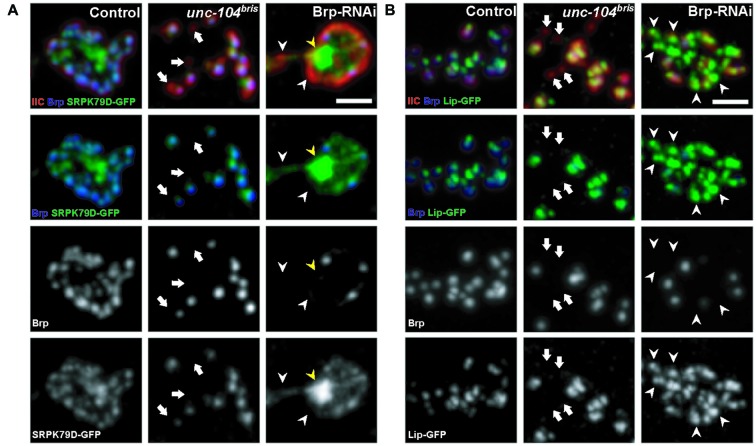
Localization of presynaptic components at the neuromuscular junction (NMJ) of unc-104bris mutant and Bruchpilot (Brp) RNAi expressing larvae. (A,B) Synaptic bouton at the NMJ costained with antibodies against postsynaptic glutamate receptor subunit IIC (GluRIIC, red in upper panel) and presynaptic Brp (blue in upper panel, gray in 3rd panel). Clustering pattern of GFP-tagged serine-arginine protein kinase at 79D (SRPK79D-GFP; A) and Liprin-α (Lip-GFP; B) respectively in synaptic bouton. (A) SRPK79D-GFP did not concentrate at Brp negative (Brp−) synapses in unc-104bris mutants (arrows). At the NMJ of larvae expressing BRP RNAi pan-neuronally (Brp-RNAi), SRPK79D-GFP failed to concentrate at Brp− synapses (white arrowheads) and large aggregation of SRPK79D-GFP is evident in the bouton (yellow arrowheads). (B) Lip-GFP does not localize to Brp− synapses in unc-104bris larvae (arrows), whereas in Brp-RNAi animals Lip-GFP is present at Brp− synapses (white arrowheads). Genotypes in (A): control (elavX-Gal4/+;;UAS-Srpk79d-GFP/+), unc-104bris (elavX-Gal4/+;unc-104bris/unc-104d11024;UAS-Srpk79d-GFP/+), Brp-RNAi (elavX-Gal4/+;;UAS-Srpk79d-GFP/UAS-Brp-RNAi). Genotypes in (B): control (elavX-Gal4/+;;PP2A-Lip-GFP/+), unc-104bris (elavX-Gal4/+;unc-104bris/unc-104d11024;PP2A-Lip-GFP/+), Brp-RNAi (elavX-Gal4/+;;PP2A-Lip-GFP/UAS-Brp-RNAi). Experiments were performed at 29°C. Scale bars: 2 μm.